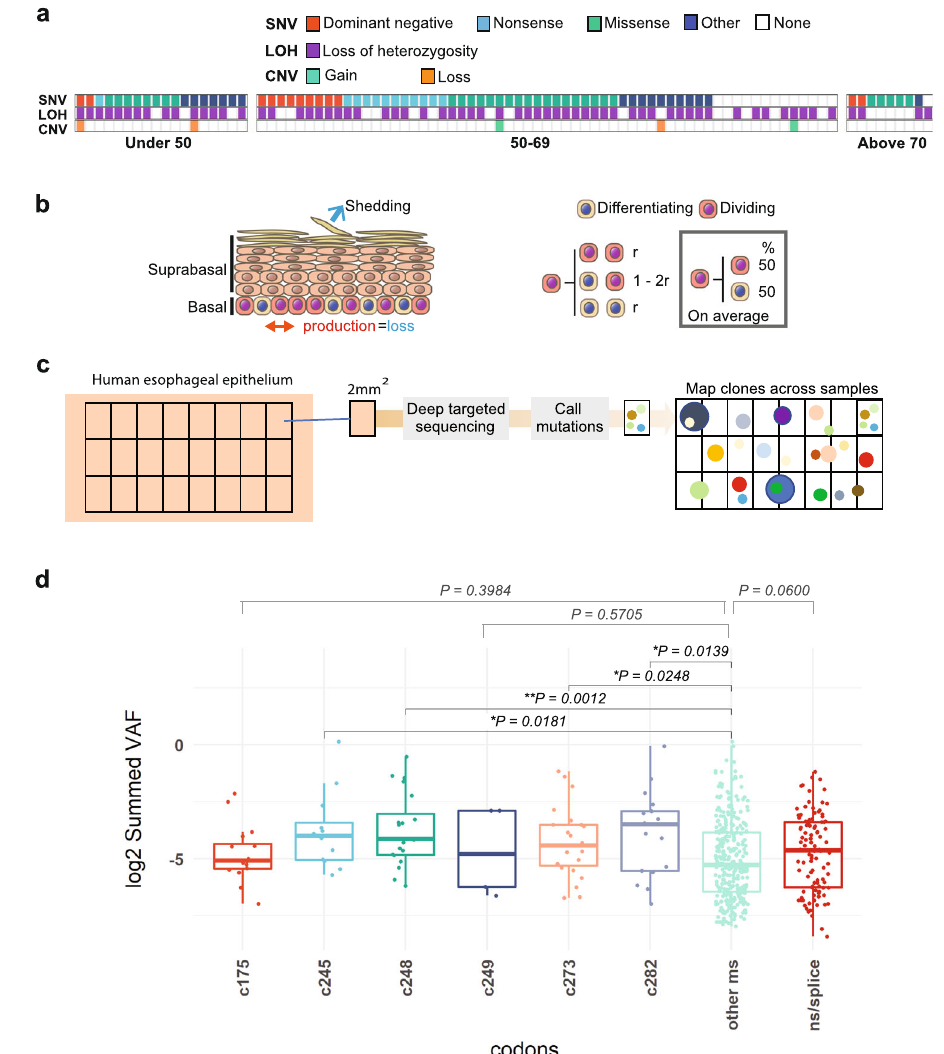
Fig. 1 | TP53 mutation in Oesophageal Squamous Cell Carcinoma (ESCC). a 88 TCGA ESCC samples were analyzed to identify the prevalence of genome altera- tions (single nucleotide variants, SNV, loss of heterozygosity, LOH & copy number variation, CNV) in the TP53 gene. 74% of samples reported LOH over TP53 and 84% reported SNVs. 64% of samples reported both SNVs and LOH over TP53 . See Sup- plementary Data 1 for source data. b Cell behaviour in basal layer of normal homoeostatic epithelium. On division, a progenitor may generate two dividing progenitors, two differentiating daughters, or one cell of each type. r is the prob- abilityofsymmetricdivisionoutcome.Onaverage,equalproportionsofprogenitor and differentiating cells are generated. c , d TP53 mutant clones in normal human oesophagus, data from ref. 2. c Protocol: normal oesophageal epithelium was cut